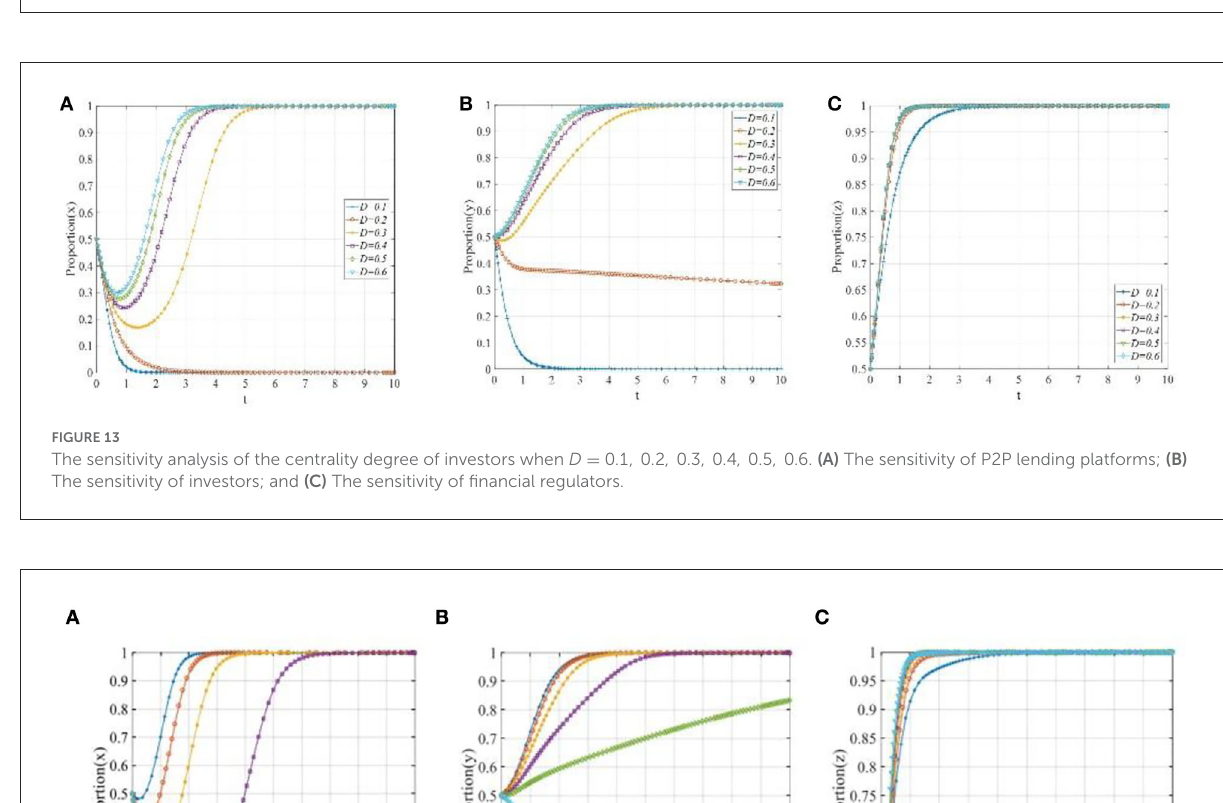
FIGURE12 The sensitivity analysis of the cost of investors when C L = 0, 0.5, 1, 1.4, 2, 4. (A) The sensitivity of P2P lending platforms; (B) The sensitivity of investors; (C) The sensitivity of financial regulators.